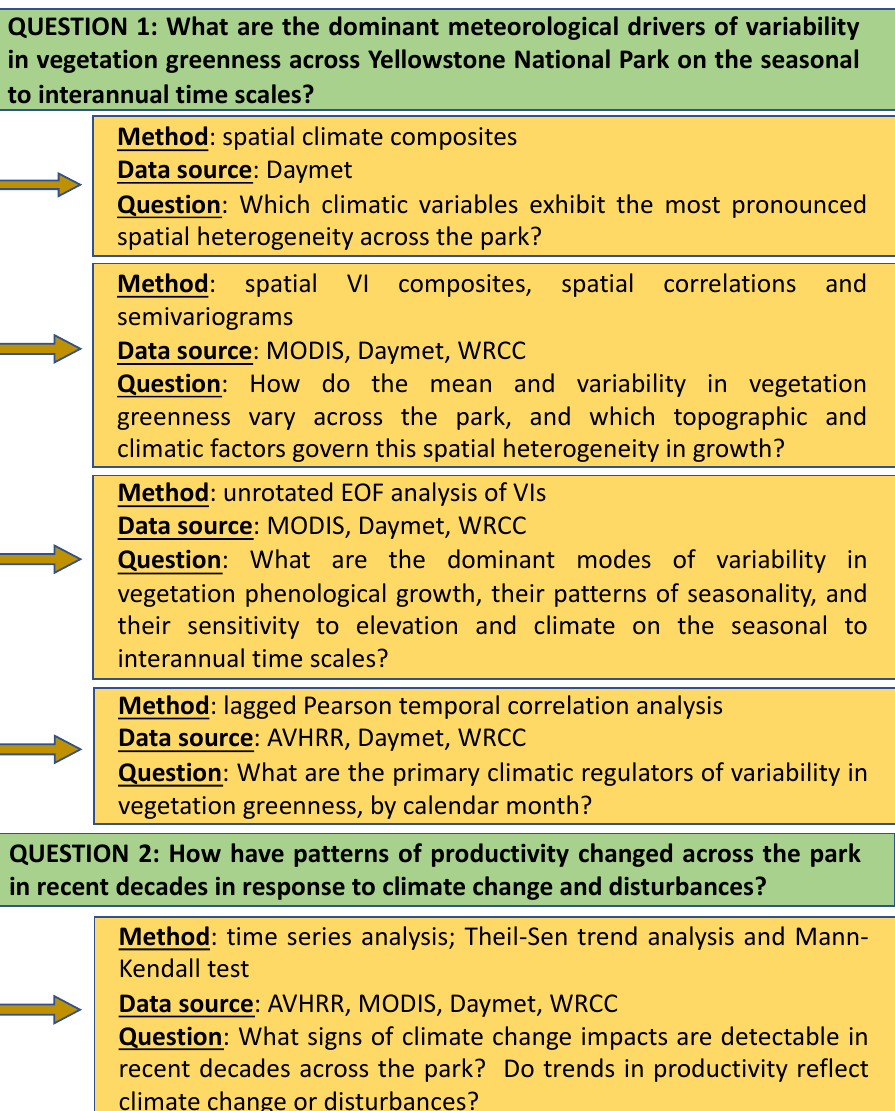
Figure 3. Research schema, summarizing the method applied in the current study.